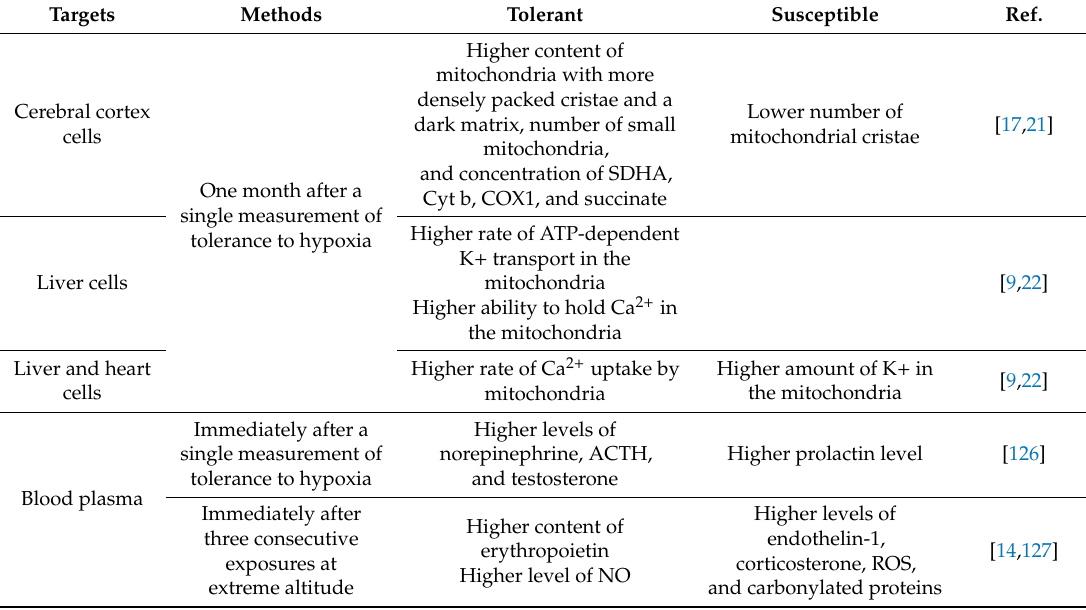
Table 2. Total studied di ff erences between tolerant- and susceptible-to-hypoxia animals, depending on the determination